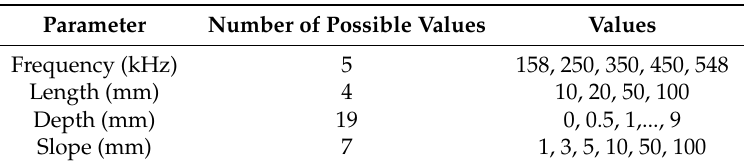
Table 1. Range of values for the different parameters of the defects.